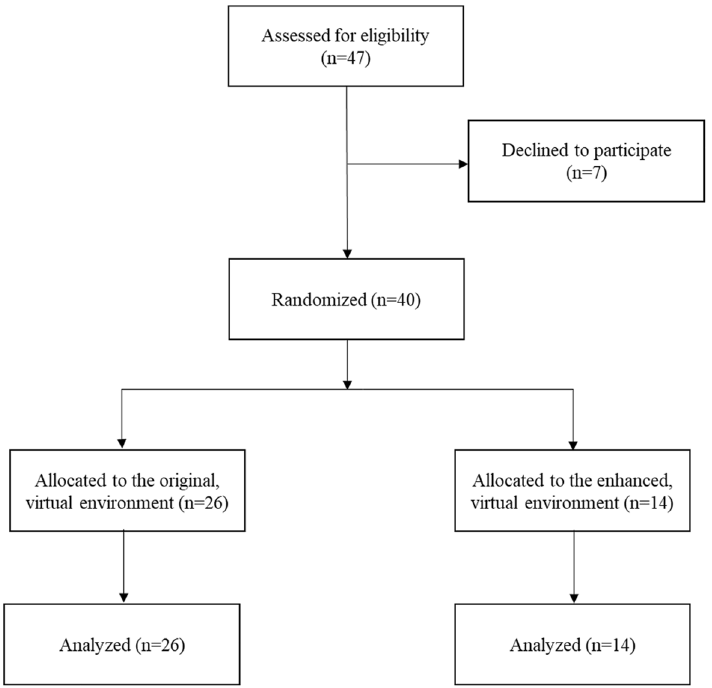
Figure 5. Study phases flow